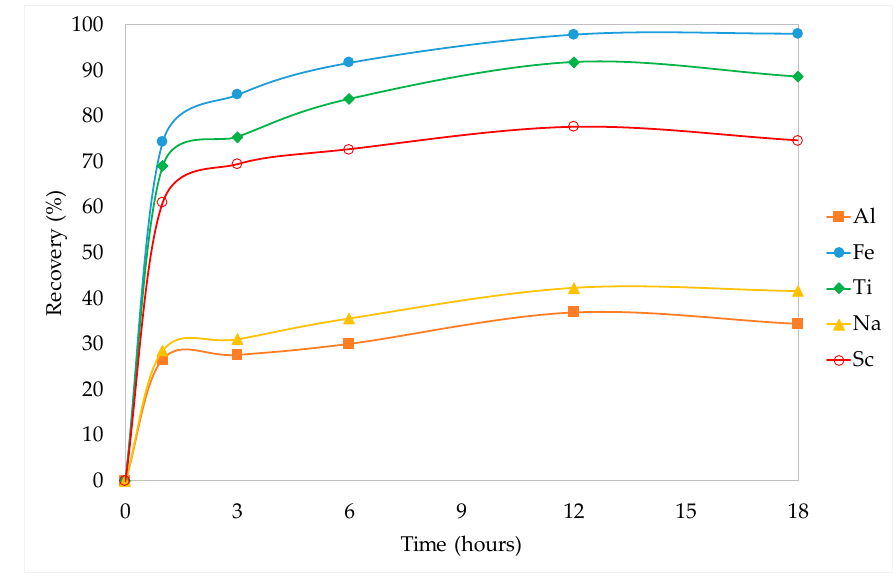
Figure 6. Kinetic curves for metals dissolution by leaching BR with [Emim][HSO 4 ] at 1, 3, 6, 12, and 18 h, 200 rpm, 200 °C, and 5% w / v pulp density.